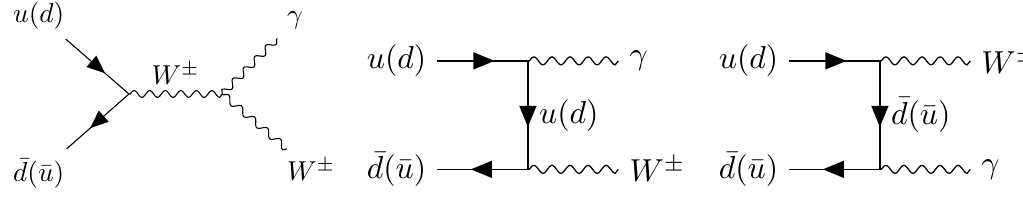
Figure 1 . Tree-level contributions to W(cid:13) production ( s , t , and u -channel respectively). For leptonically decaying W one should add an extra diagram where the photon is emitted by the lepton